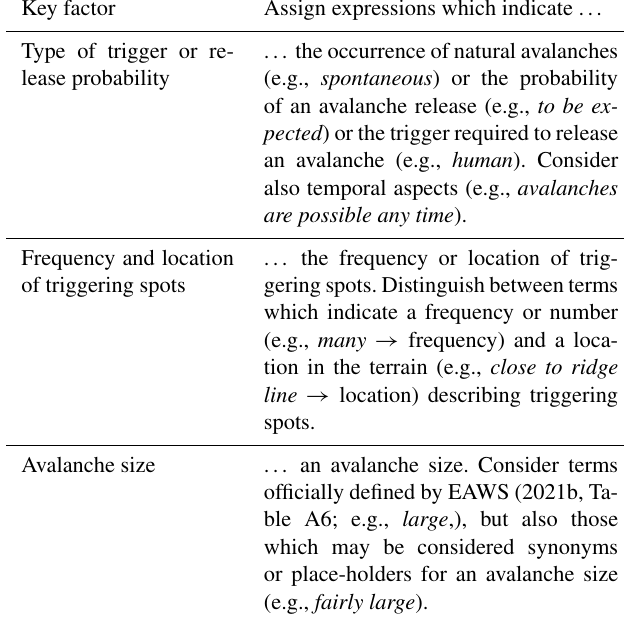
Table A1. Annotation